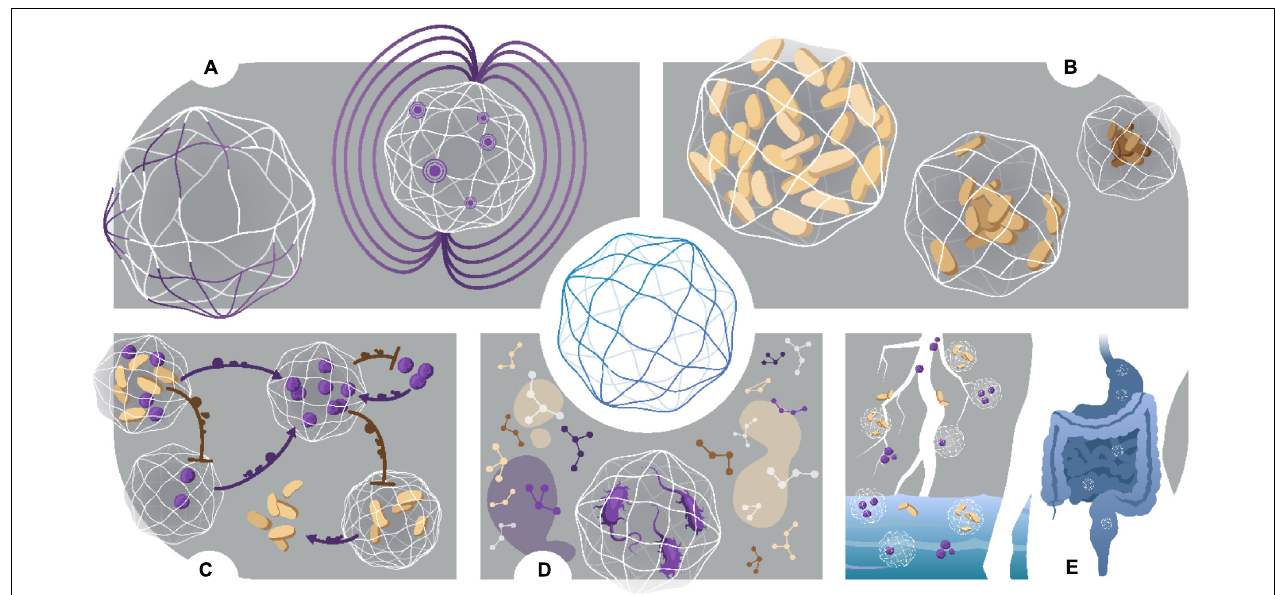
FIGURE 5 | Characterization and applications of nanocultures. (A) Chemical and Magnetic functionalization. Nanocultures are custom designed to fit specific applications. Addition of functional group DMAA into the polymer membrane increases free volume, changing the selective permeability properties of the membrane. Similarly, addition of magnetic oxide allows for easy retrieval after nanocultures are freely suspended in an environmental sample. To collect nanocultures, a magnet is simply moved over the sample. (B) Investigation of osmotic stress. Nanocultures may be used to study single cell and/or community response to physical insults, such as osmotic stress. (C) Biochemical Interactions. Intra- and Inter-species dynamics may be studied in real time, whereby the semi-permeable membrane provides physical containment of the cells but allows for cross signaling between nanocultures in the form of small molecules. Furthermore, secreted small molecules may be studied for biological relevance, such as drug discovery or beneficial secondary metabolites for symbiotic relationships. (D) Growth of fastidious species. Growth of fastidious species has been demonstrated by culturing C. difficile under a microscope, negating the use of anaerobic jars or chambers. (E) Culturing the “unculturable.” Nanocultures can be used to successfully culture the “unculturable” from many environmental sources, such as soil, marine and human